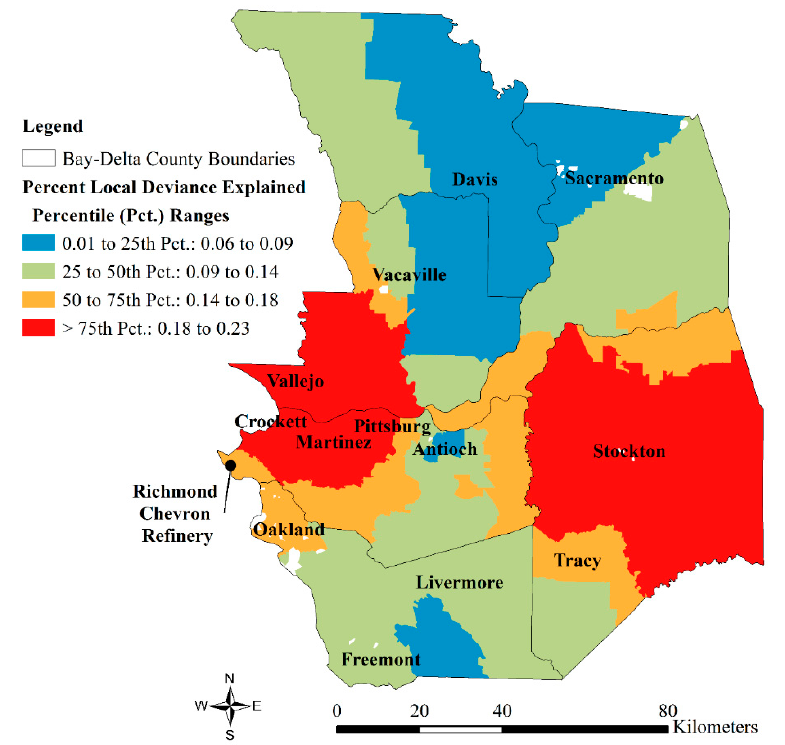
Figure 8. GWLR model fit statistic: Percent local deviance explained by block group.